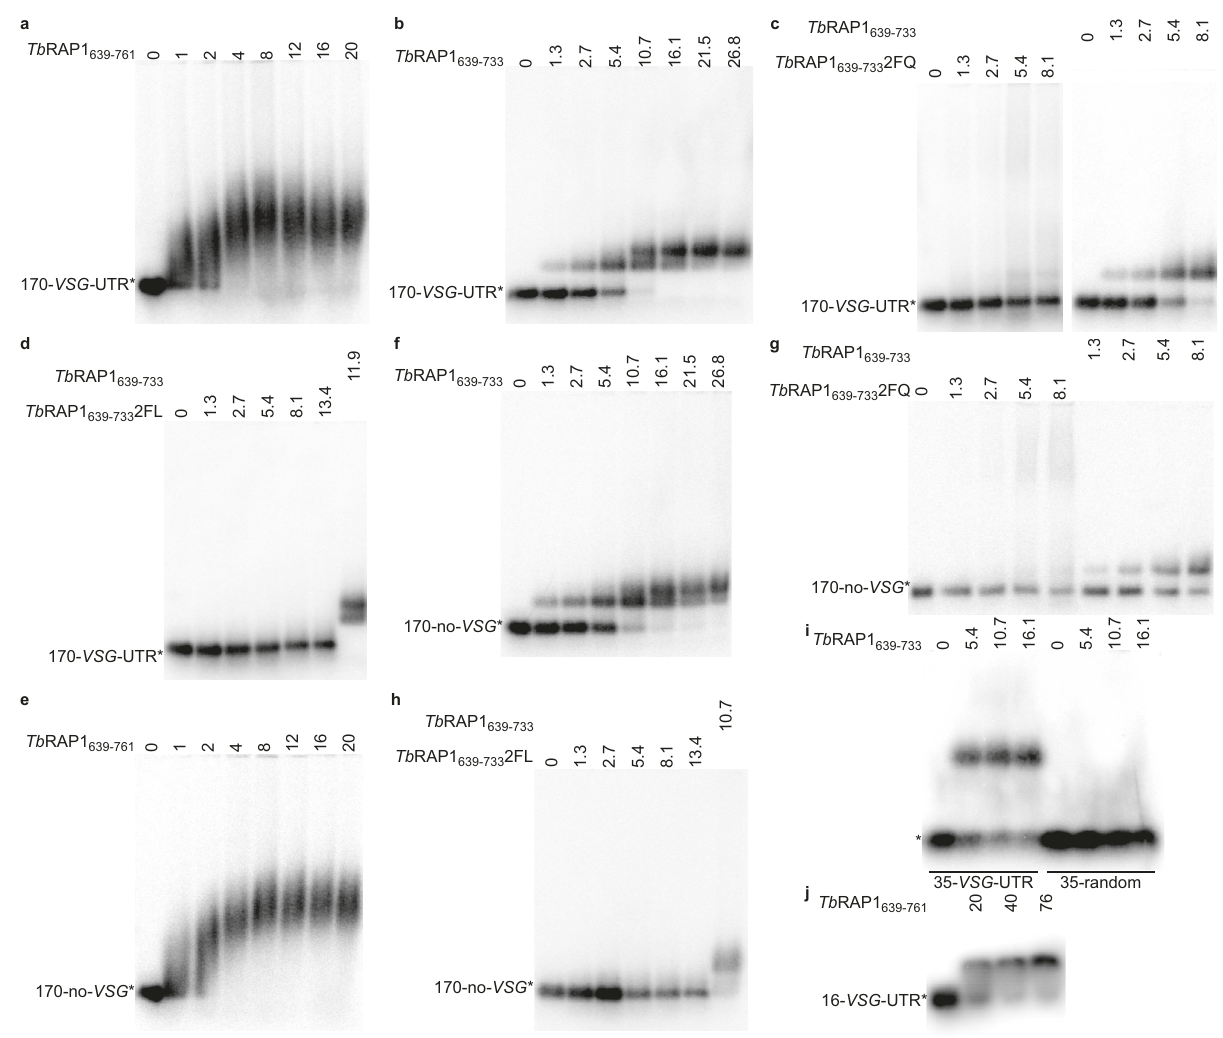
Fig. 3 | Characterization of Tb RAP1 RRM ’ s RNA binding activity by EMSA. Untagged recombinant Tb RAP1 639-761 ( a , e , j ), Tb RAP1 639-733 ( b – d , f – i ), Tb RAP1 639- 733 2FQ ( c , g ), and Tb RAP1 639-733 2FL ( d , h ) were incubated with 170- VSG -UTR ( a 170-no- VSG ( e – h ),35- VSG -UTR( i ),35-random( i ),or16- VSG -UTR( j )(Supplementary